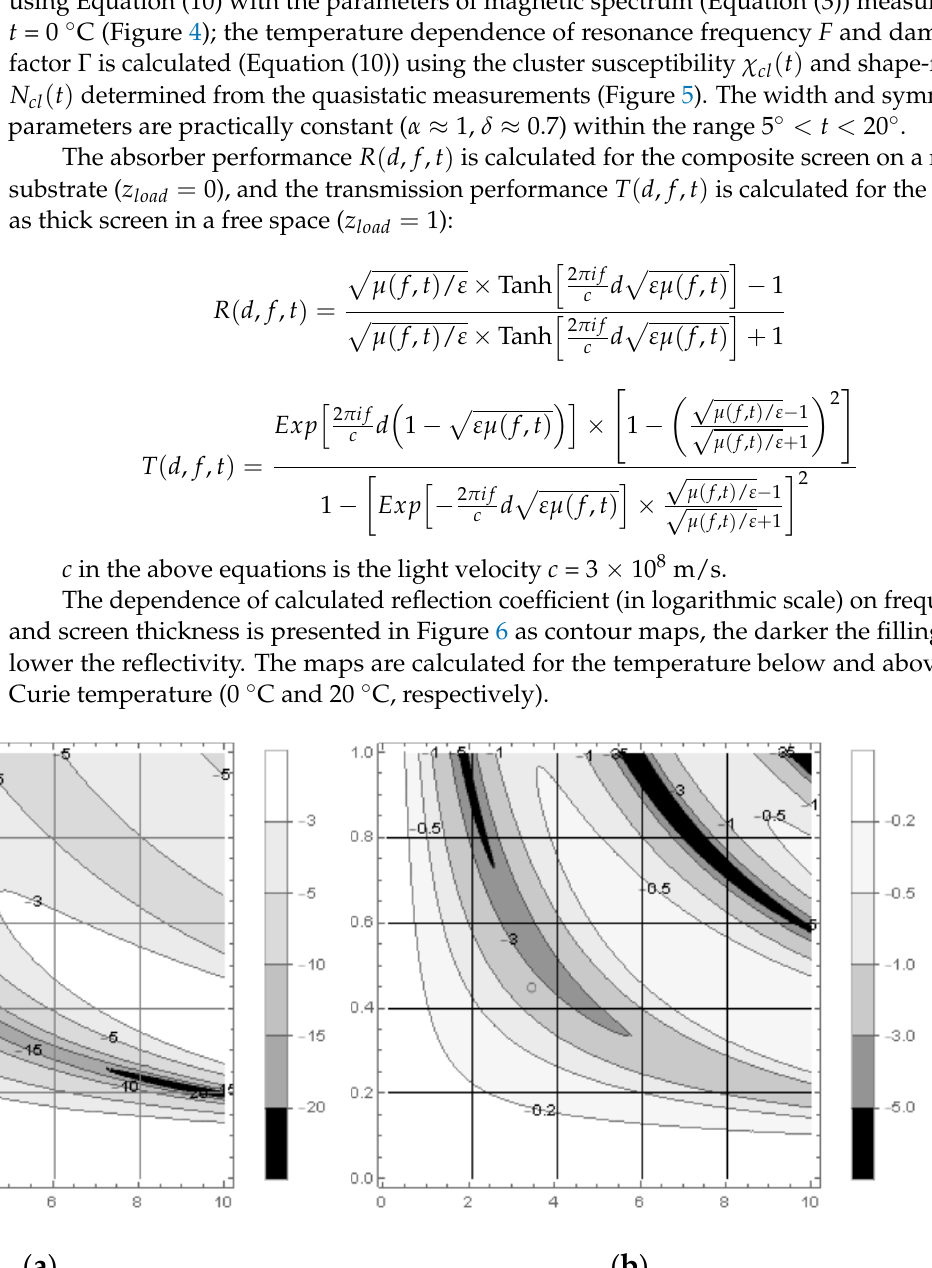
( b ) Figure 7. ( a ) Simulated dependence of reflection and transmission coefficients on temperature at f = 3.5 GHz. ( b ) Frequency dependence of reflection coefficient for shorted sample measured at 5 ° С and 25 ° С . 5